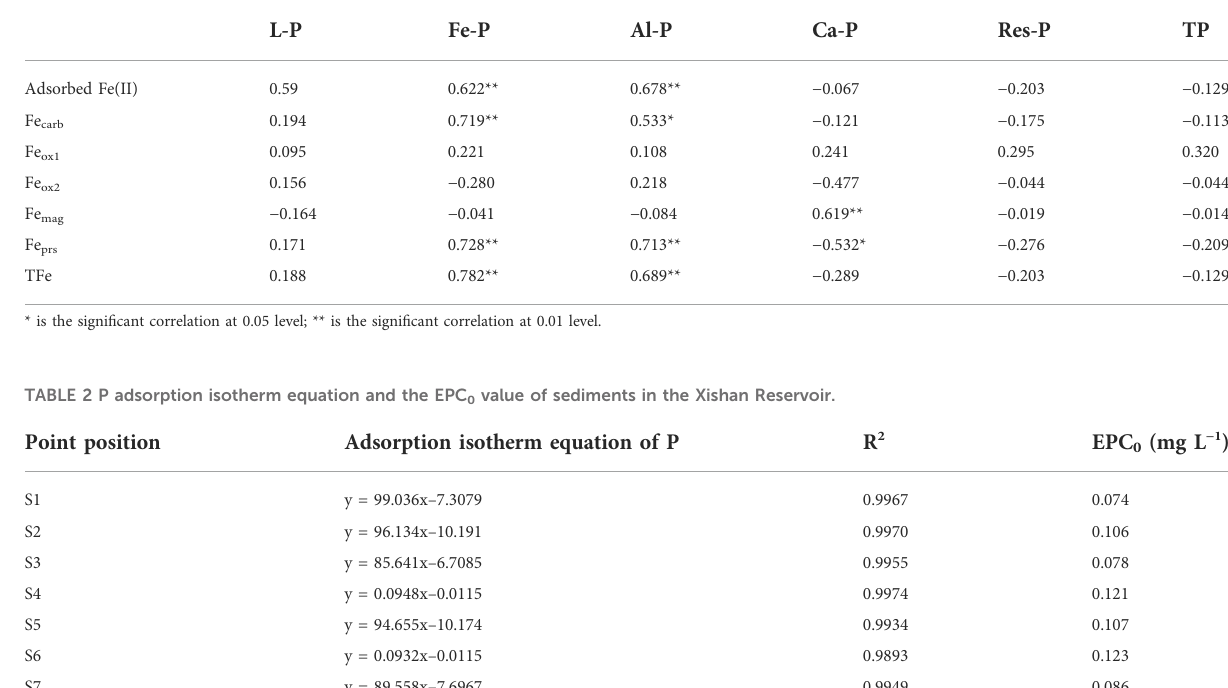
TABLE 1 Correlation analysis of P fractions and Fe fractions in soils and sediments of the Xishan Reservoir drainage area (n = 17).